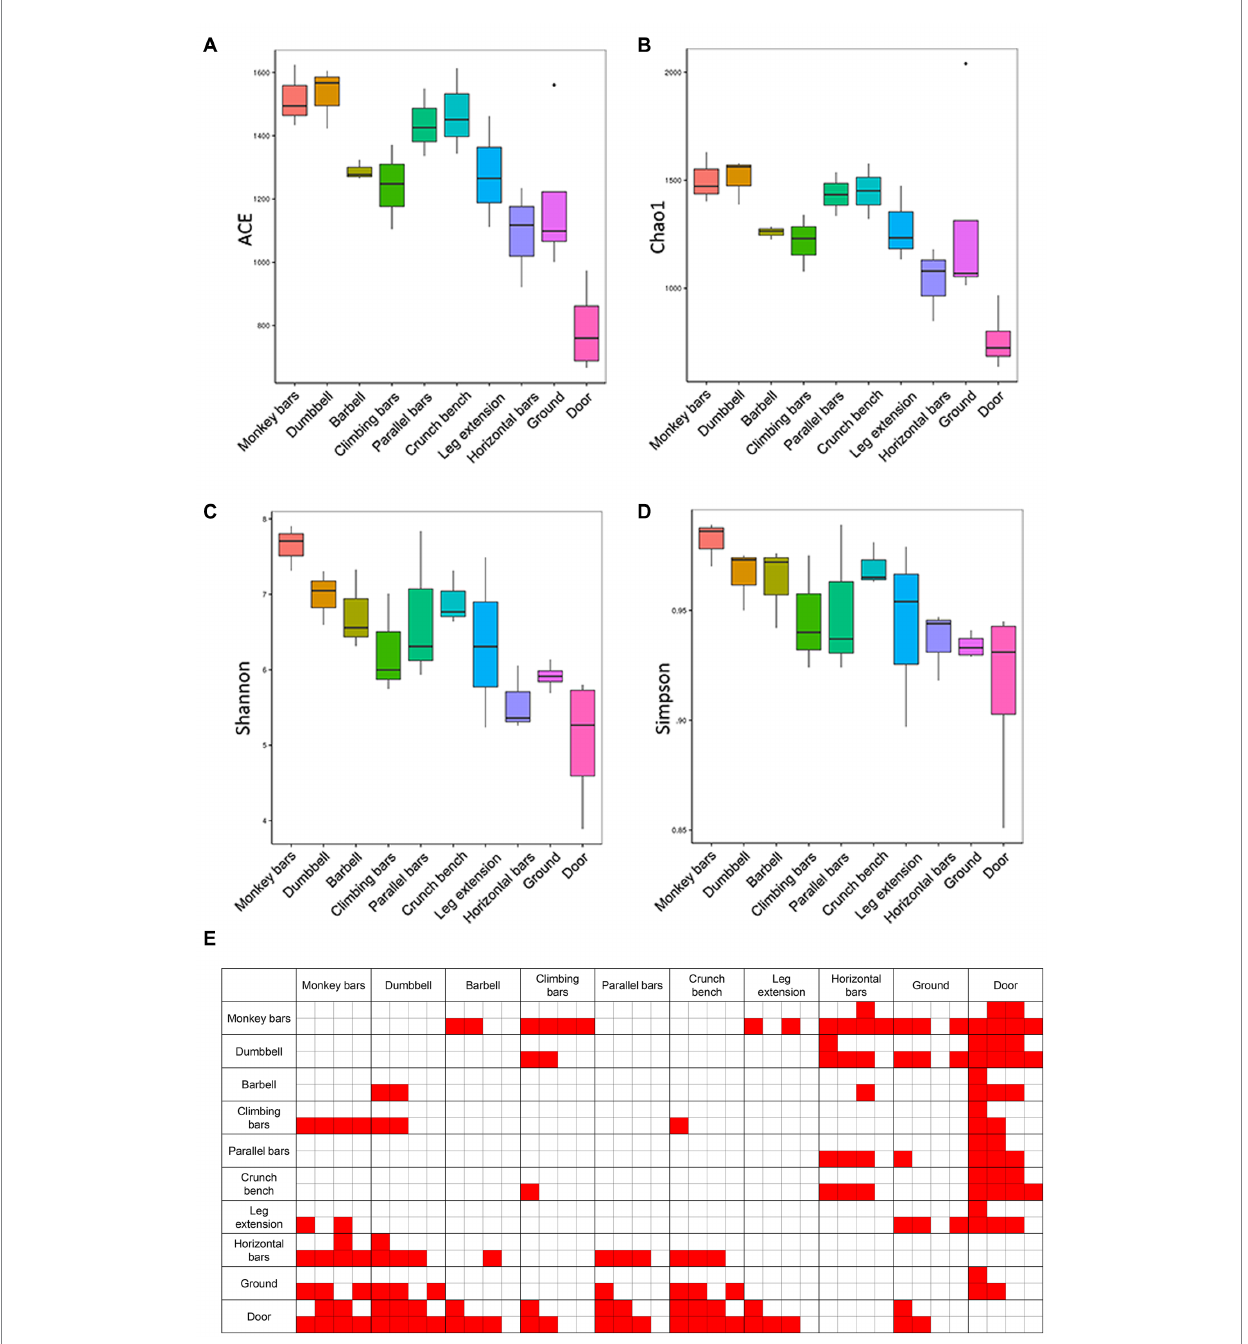
FIGURE 2 Abundances and diversities of microbial communities on the surfaces of gymnastic equipment. (A) ACE estimators. (B) Chao1 estimators. (C) Shannon indices. (D) Simpson indices. (E) Statistical tests of α -diversity indices. Red, represents p -values <0.05. In each comparison box from left to right are comparisons of the ACE estimators, Chao1 estimators, Shannon indices and Simpson indices. The top four small boxes in each comparison box mark the results of the Tukey test and the bottom four small boxes mark the results of the Wilcoxon